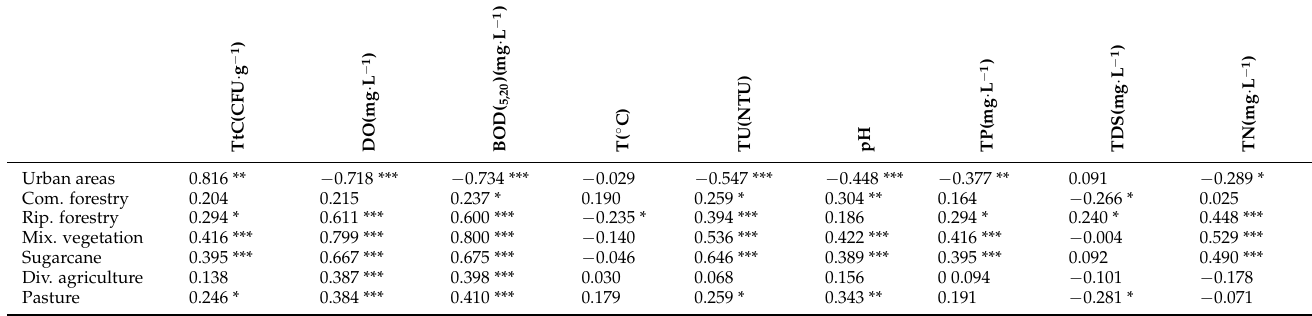
Table 3. Correlation between land uses and water quality (Pearson’s R).